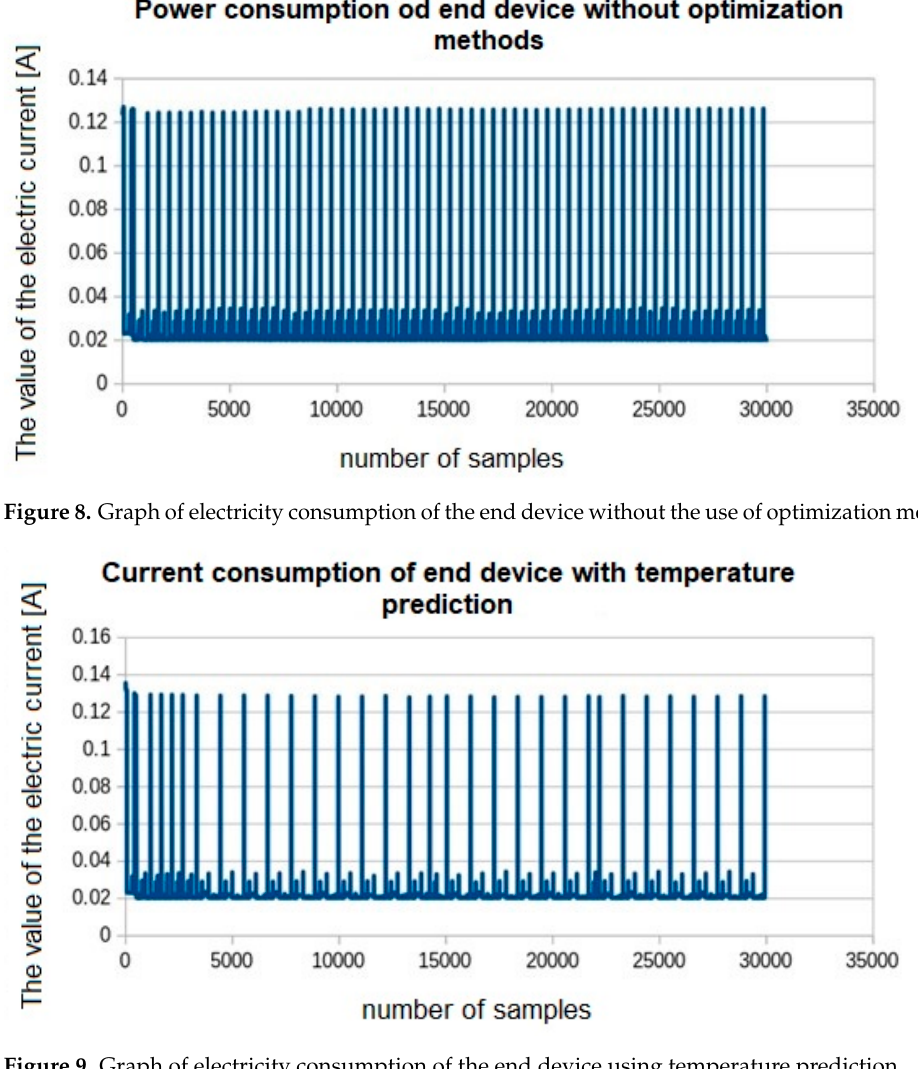
Figure 9. Graph of electricity consumption of the end device using temperature prediction.